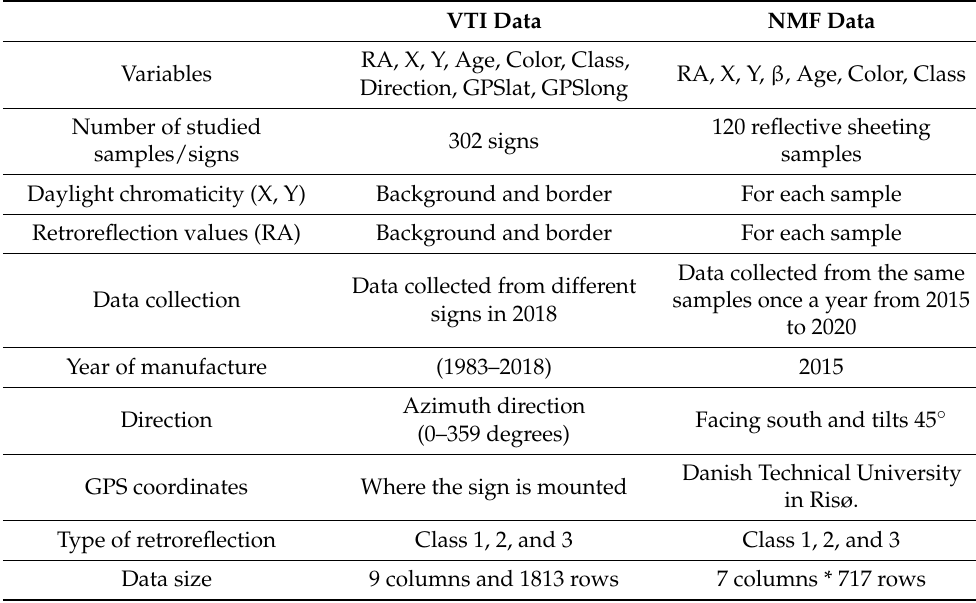
Table 2. Description of the datasets used in this